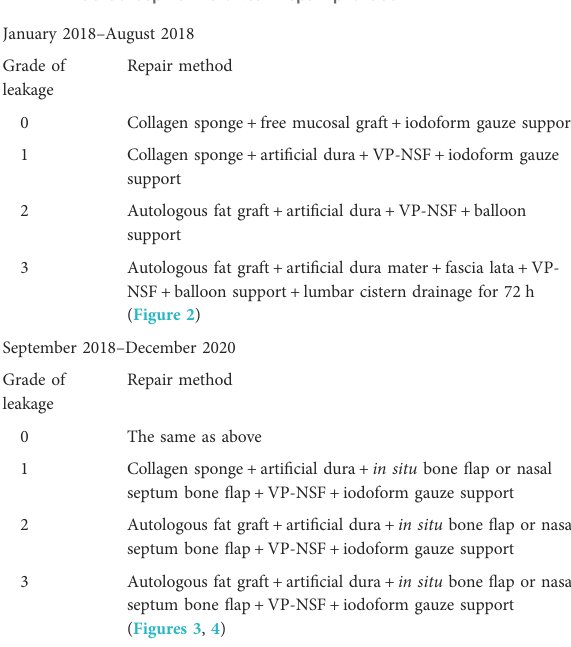
TABLE 1 Cerebrospinal fl uid leak repair